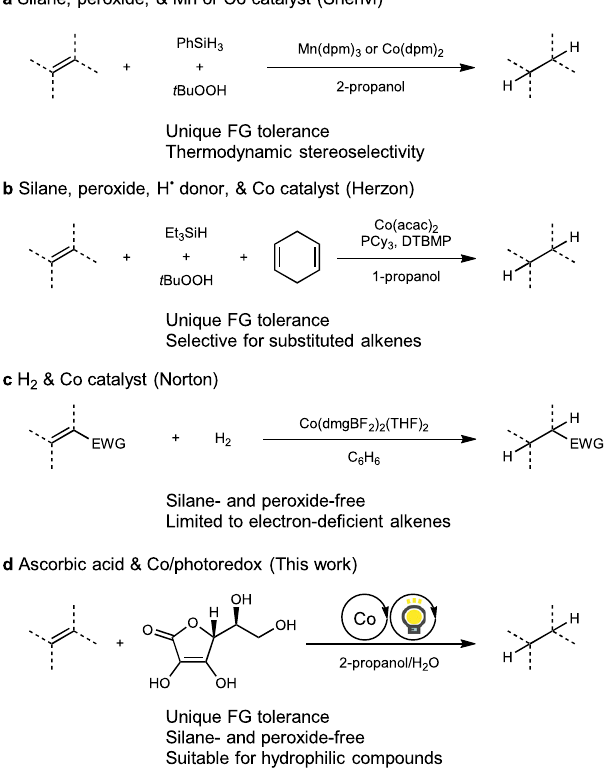
Fig. 1 Catalytic HAT hydrogenation of alkenes. a Shenvi ’ s method.